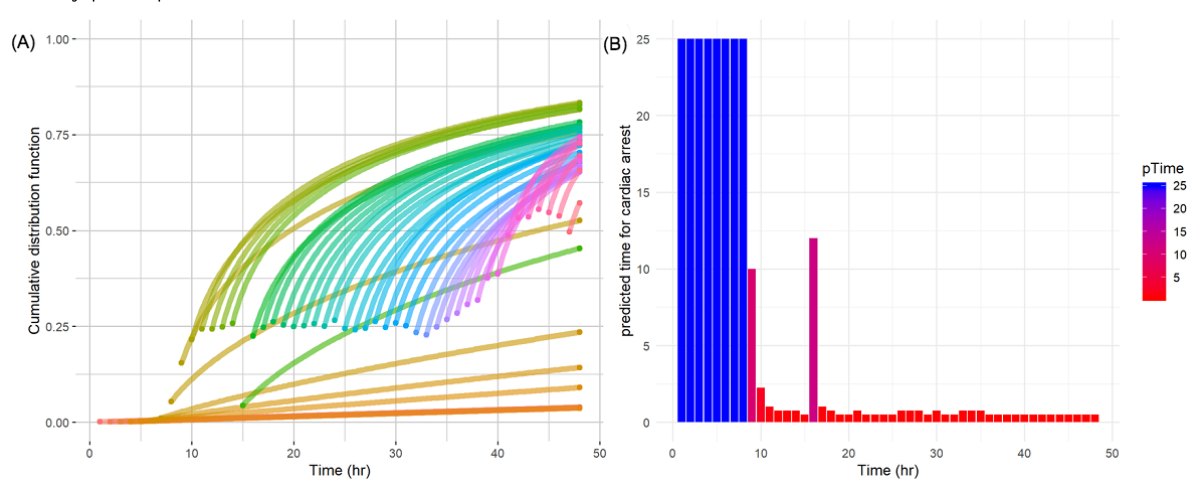
Figure 6. (A) Cumulative distribution function lines from the predicted time point to censoring time point for a patient with cardiac arrest at 48 time points; Each function line is color-coded. (B) Predicted hours remaining until a patient has cardiac arrest; the y-axis was limited to less than 25 hours for readability. pTime: predicted